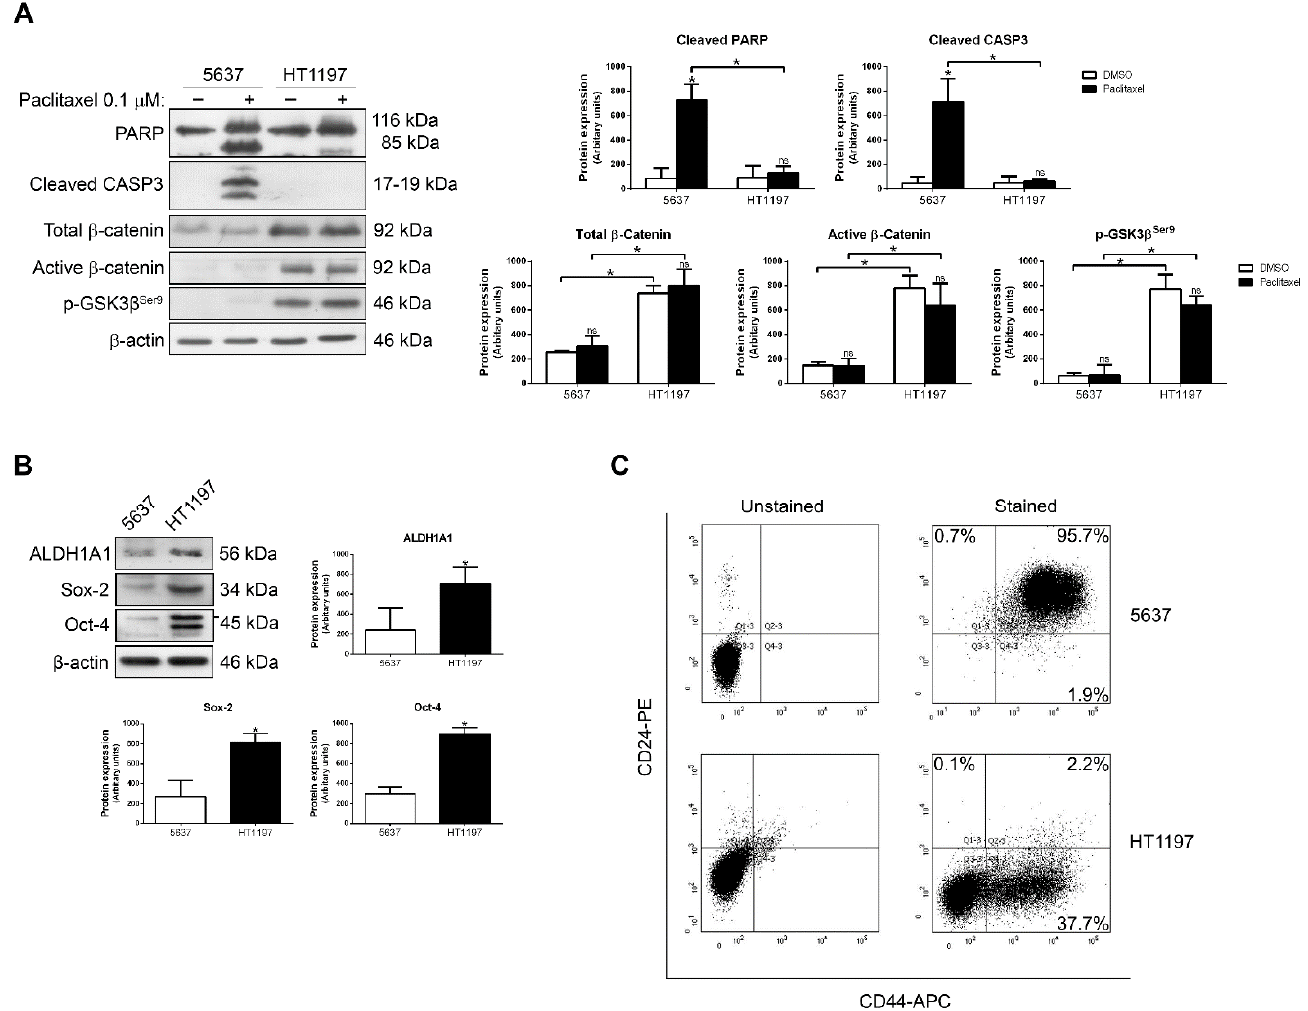
Figure 1. Paclitaxel-resistant HT1197 cells show β -catenin overexpression and CSC-like properties. ( A ) Western blots of PARP, cleaved caspase-3, total β -catenin, active β -catenin and p-GSK3 β Ser9 in 5637 and HT1197 cells treated with DMSO (vehicle) or 0.1 µM paclitaxel for 48 h, and ( B ) Western blots of CSC markers ALDH1A1, Sox-2 and Oct-4 in untreated 5637 and HT1197 cells. β -actin was used as a loading control. Histograms show the densitometric analysis of the indicated proteins. Data are presented as mean ± SD. * p value < 0.05 from Student’s t test (n ≥ 3). ns, not significant. ( C ) Flow cytometry detection of CSC-like CD44 + /CD24 − populations in 5637 and HT1197 cells. PE, phycoerythrin. APC, allophycocyanin.